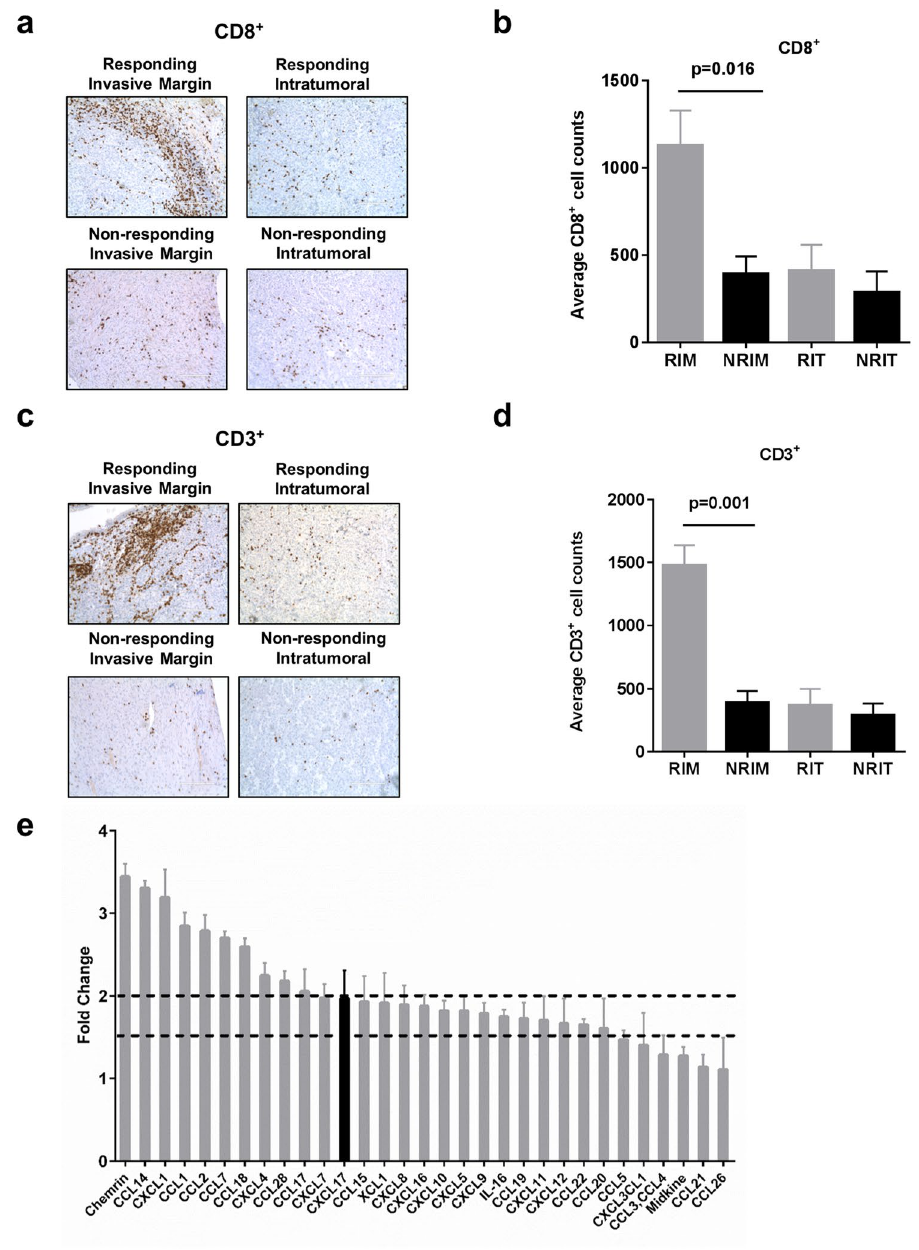
Figure 1. Responding tumors show increased T-cells and Chemokines prior to treatment. ( a , c ) Representative CD8 + and CD3 + IHC staining of the invasive tumor margin and intratumoral region in pretreatment metastatic melanoma tumors (responding N = 4, non-responding N = 4). Tumor compartments were demarcated by a dermatopathologist. ( b , d ) Average CD8 + and CD3 + cell counts for responding and non-responding tumors’ compartments. T-cell counts were generated by averaging the counts of 10 randomly selected fields at 20x objective for each tumor compartment (10 invasive margin; 10 intratumoral). Individual tumor counts can be found in Extended Data Fig. 1. RIM = Responding invasive margin; NRIM = Non-responding invasive margin; RIT = Responding intratumoral; NRIT = Non-responding intratumoral. ( e ) Reverse western assay with the human chemokine antibody arrays (R&D Systems). Results are ratios of summed intensities of responding and non-responding tumors, ratios > 2 were defined as a significant change. Chemokine signaling was higher in responding tumors with 10 of 31 chemokines showing > 2 fold change. All error bars denote the